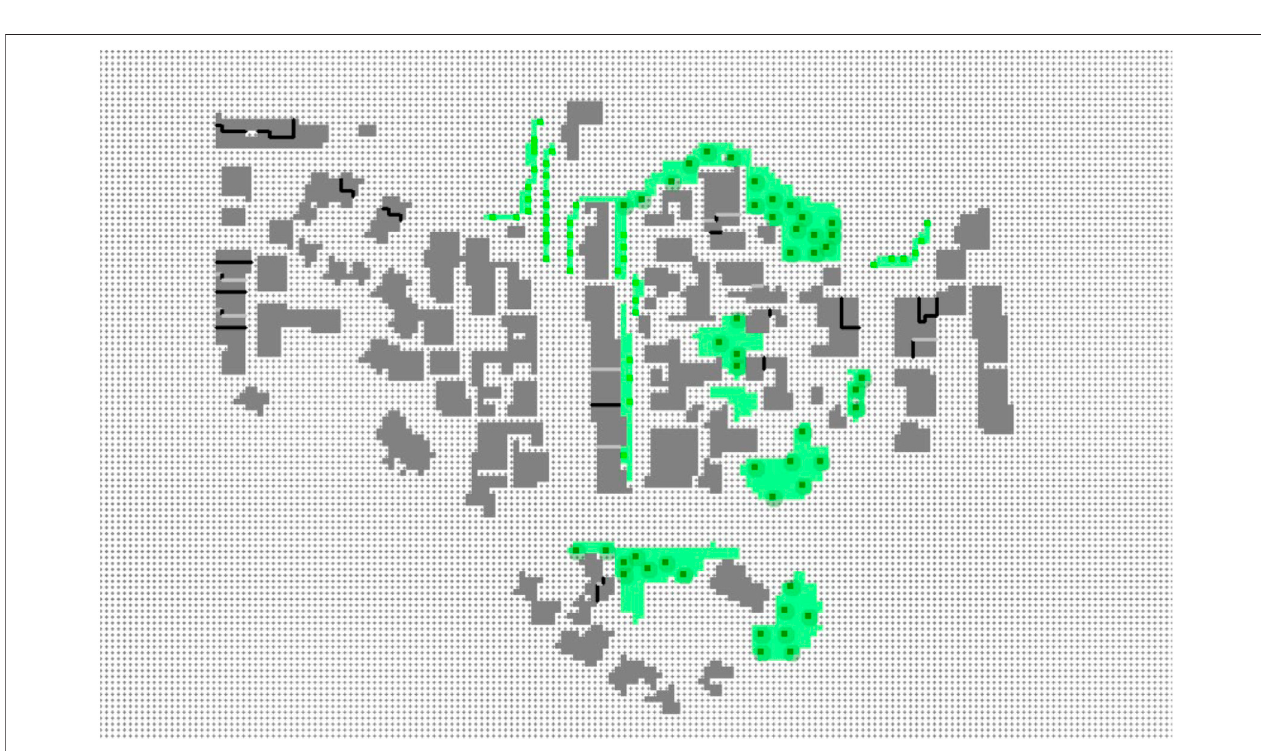
FIGURE 5 | ENVI-met model of the case study area.